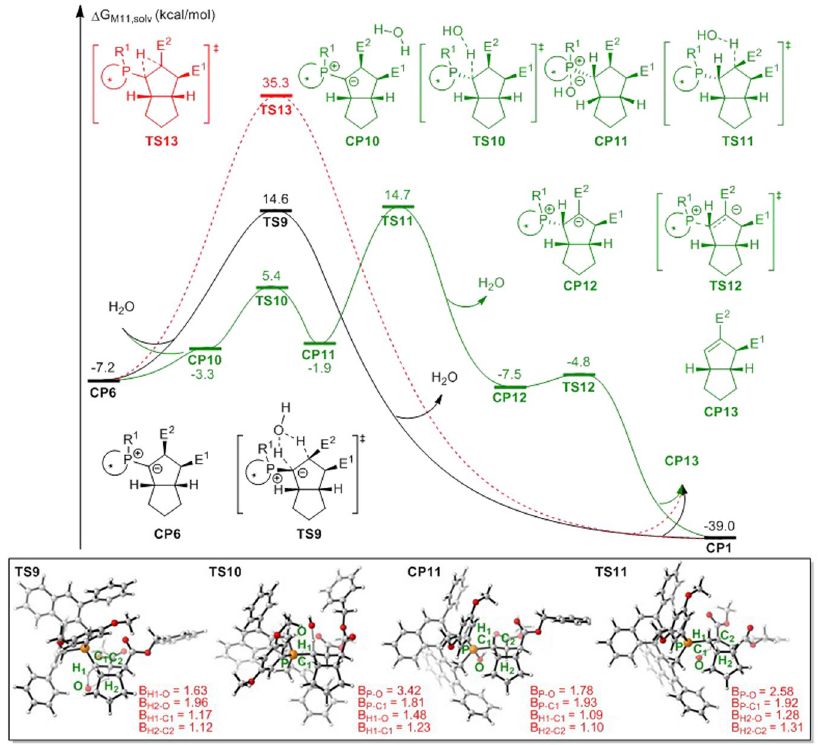
Figure 7. Free energy profiles for the [1,2]-proton shift process (E 1 = CO 2 Bn, E 2 = CO 2 Me). Values are given by kcal/mol and represent the relative free energies calculated by M11 method in toluene solvent. The values in geometry information are given by